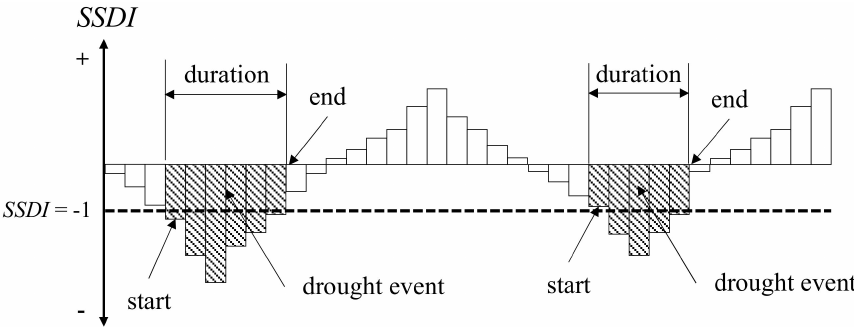
Figure 2. Drought event identification using the run theory for a given threshold level